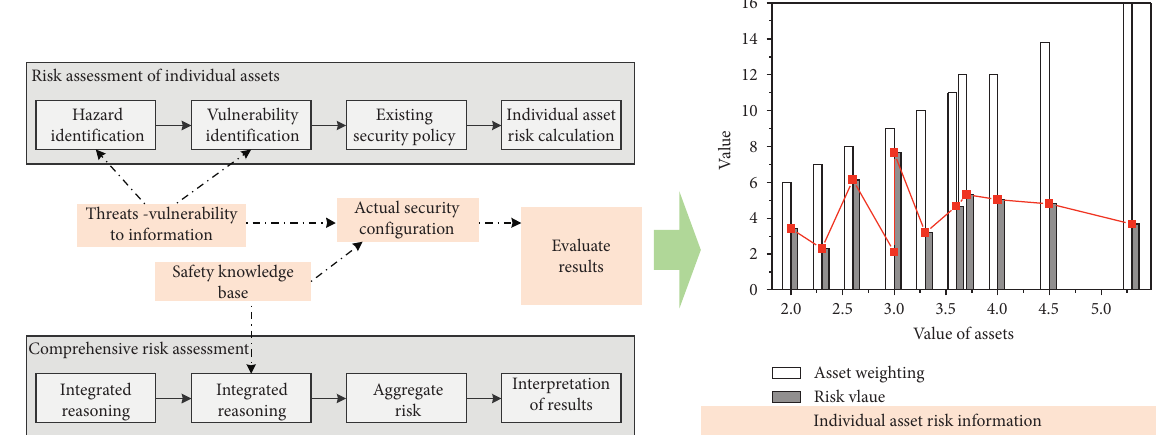
Figure 8: Distribution route and demand for goods at each distribution point.